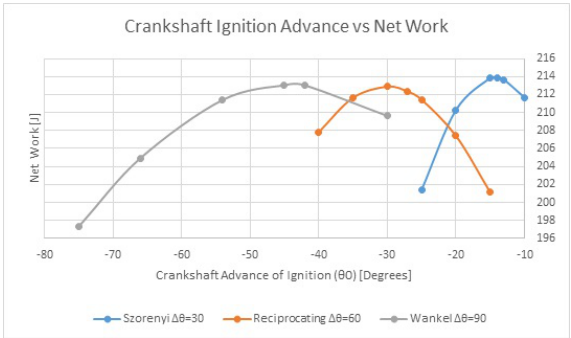
Fig. 7: Variation of net work produced by the Szorenyi engine, Wankel engine and the reciprocating engine at different advance of ignition